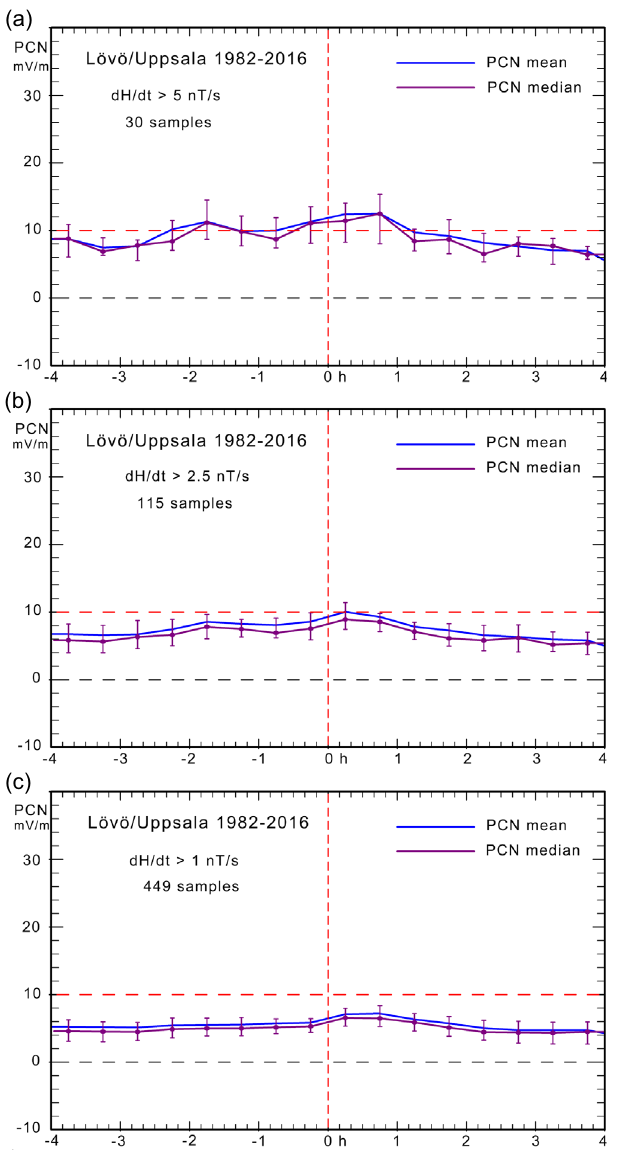
Fig. 11. Occurrences at subauroral latitudes of substorms with steep gradients vs. PCN